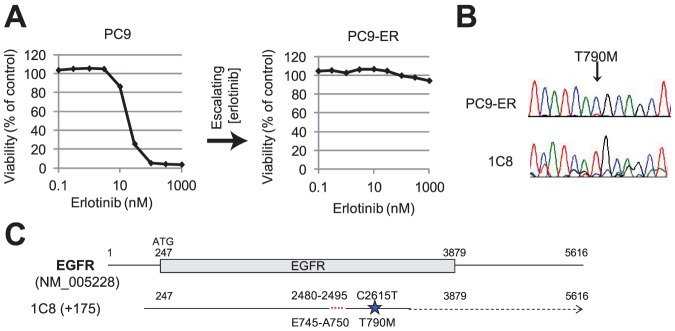
Screening for resistance alleles.
A. Selection of PC9 cells in media containing increasing concentrations of erlotinib resulted in the PC9-ER line, which is unaffected by doses of erlotinib up to 1 µM. B. The IL3-independent Ba/F3 clone 1C8 recovered by cDNA library screening of PC9-ER cells contains both the Δex19 activating mutation and the T790M mutation in EGFR. C. Sanger sequencing shows that only a small fraction of EGFR amplified from PC9-ER cells harbors the T790M alteration, in contrast with 1C8.